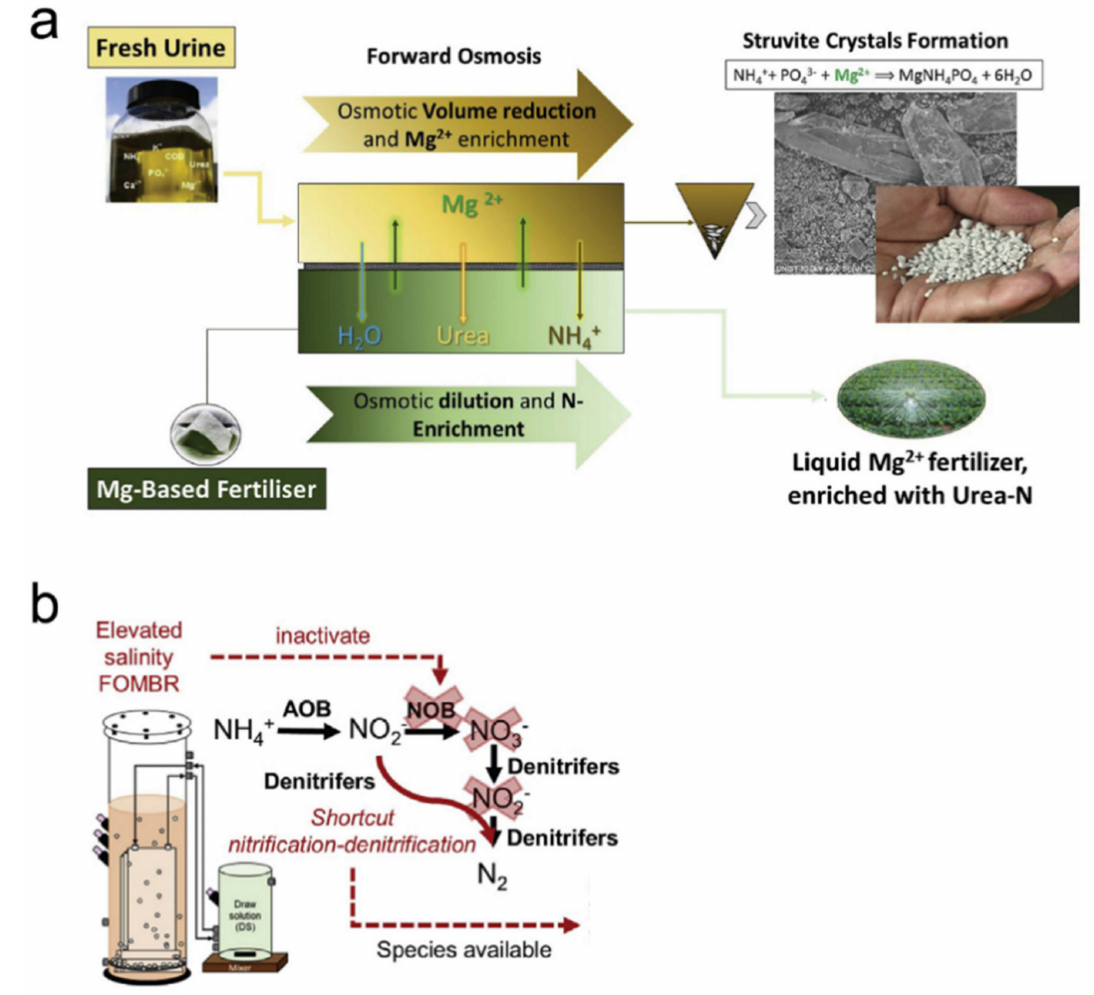
Figure 8. ( a ) Schematic diagram of the FO process for phosphorous and nitrogen recovery from urine, reprinted with permission from [121], and ( b ) zchematic diagram of a nitrification-denitrification shortcut built in FOMBR system, reprinted with permission from